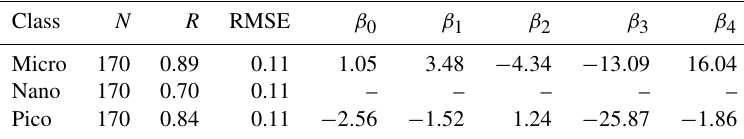
Table 1. Parameter β i values for the PSC model development.